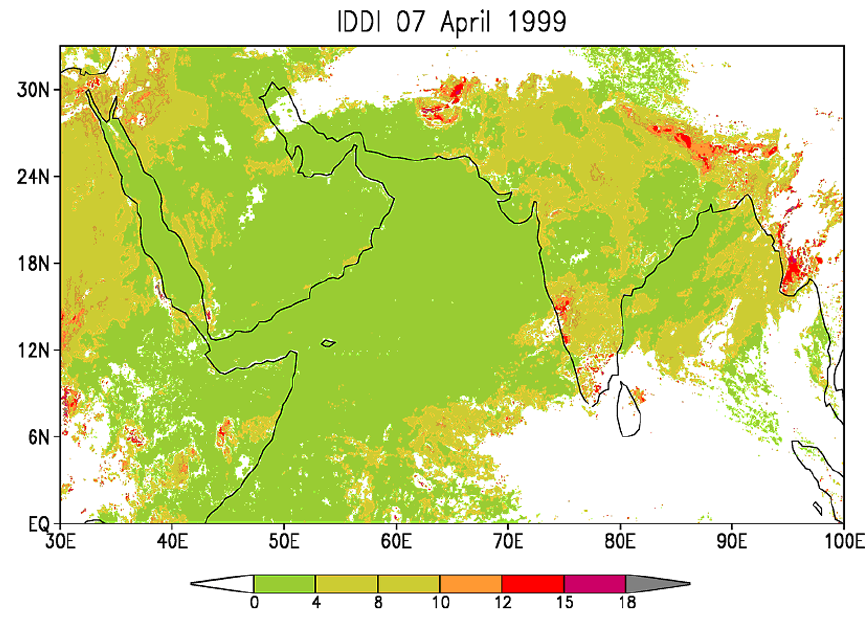
Fig. 7. The final IDDI image (in K) after cloud screening the difference image. This image represents the regional distribution of dust aerosols.